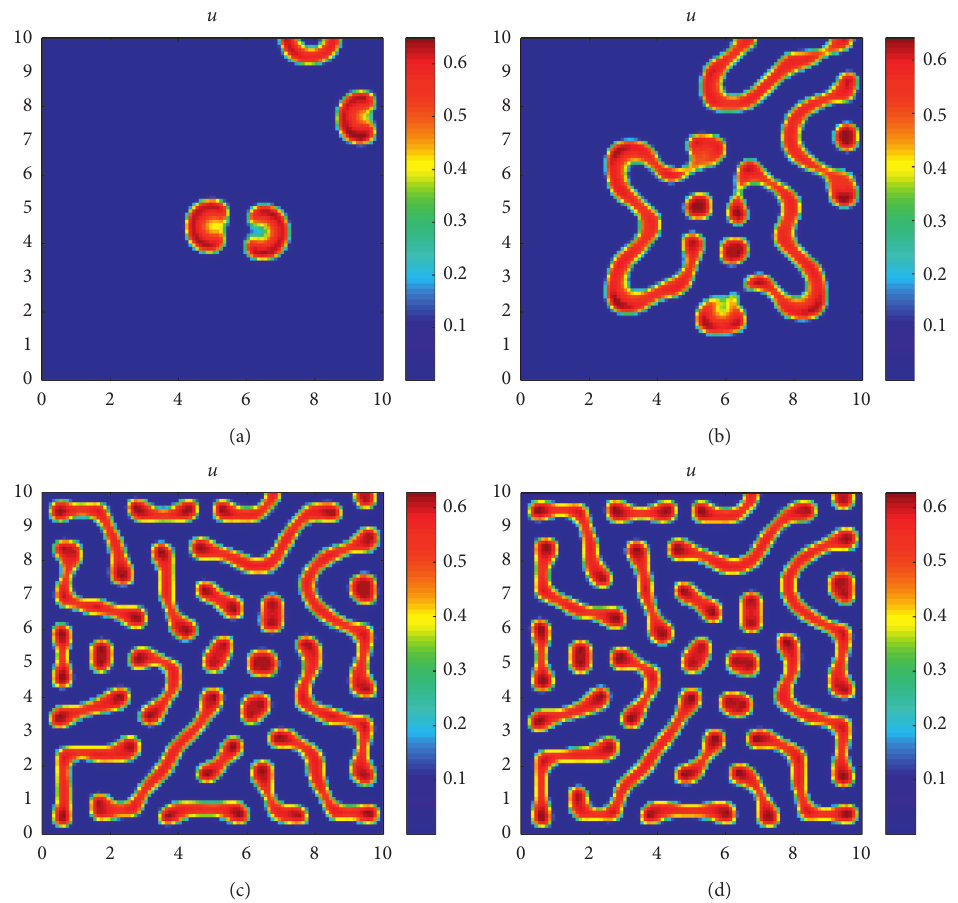
Figure 3: Mixture patterns obtained with model [1] for A � 0 . 1 and τ � 0. Time: (a) t � 100, (b) t � 500, (c) t � 2000, and (d) t � 5000.